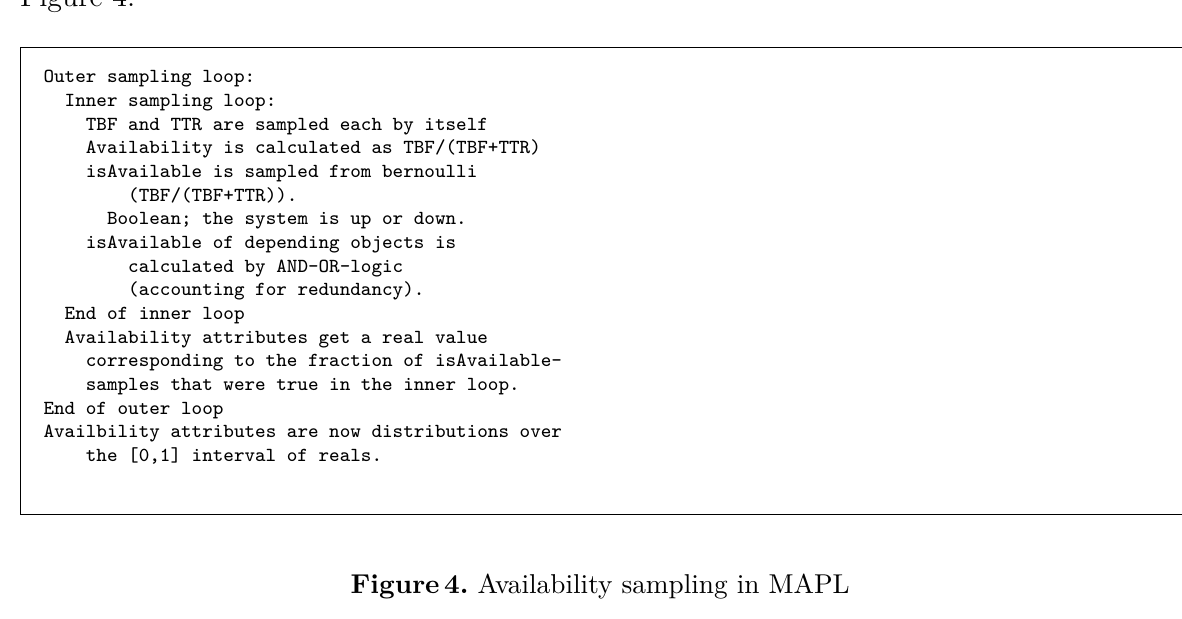
Figure 4. Availability sampling in MAPL